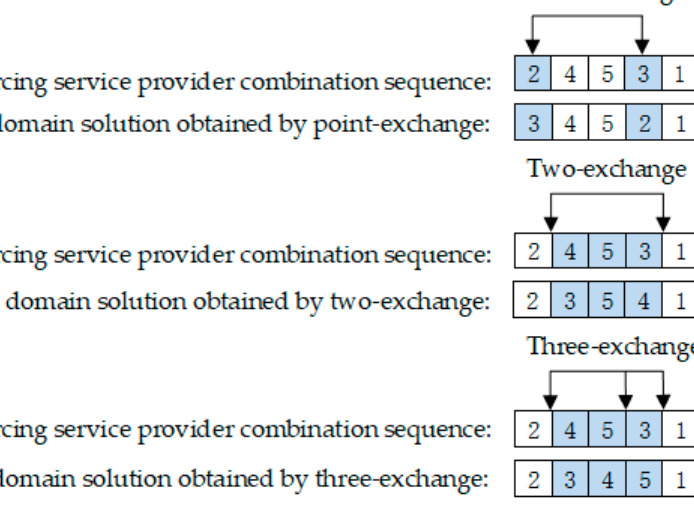
Figure 5. Neighborhood search methods of point-exchange, two-exchange, and three-exchange.